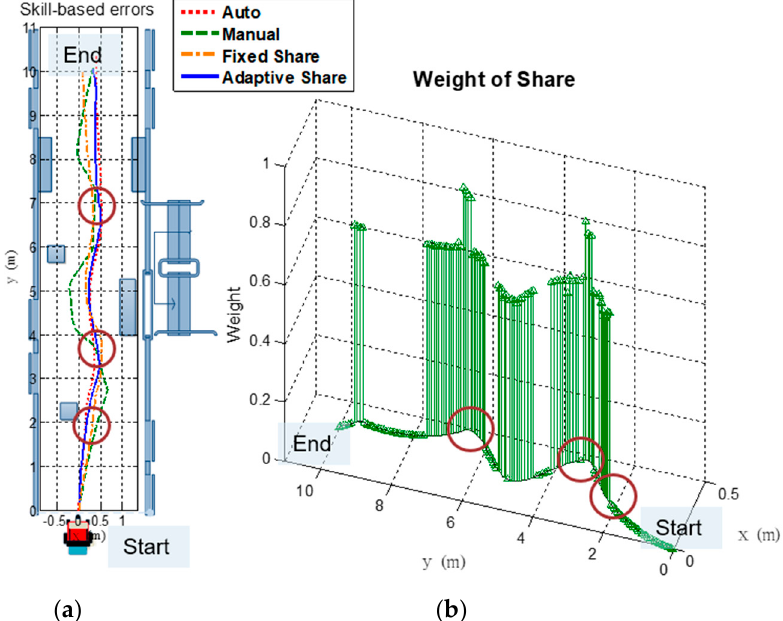
Figure 9. Experimental results of the skill-based error operation. ( a ) The trajectories of the four control modes. ( b ) Changes of the weights of adaptive shared control.